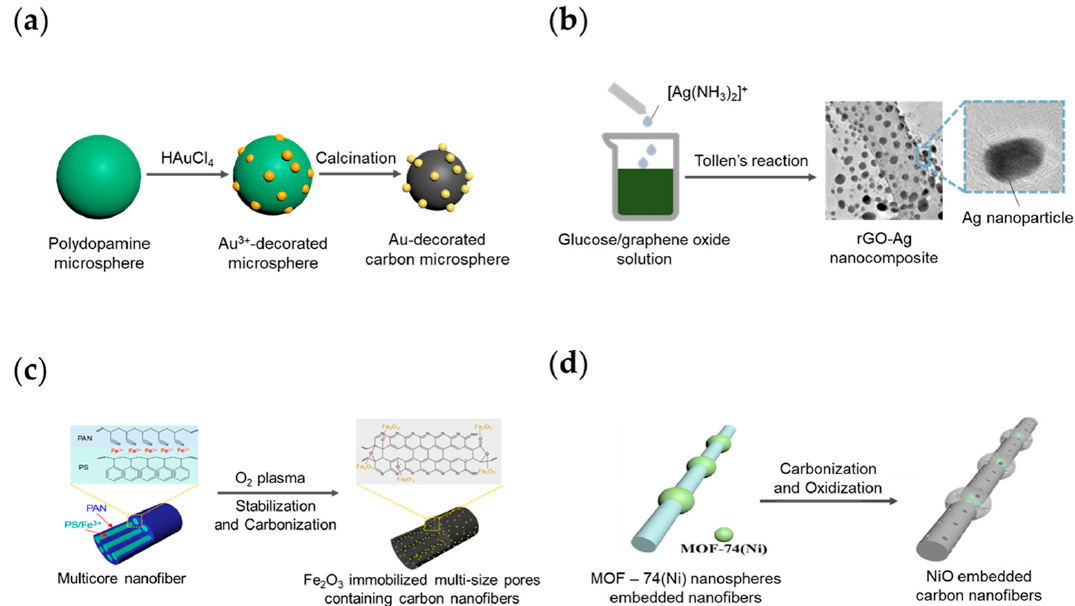
Figure 8. ( a ) Carbon spheres surface modified with in situ synthesized gold nanoparticles [78]. ( b ) The rGO-Ag nanocomposite was synthesized by modified Tollens’ reaction [79]. ( c ) The plasma oxygen process is used to immobilize iron(III) oxide in the multi-dimensional pore structure of carbon nanofibers [80]. ( d ) MOF-74(Ni) nanospheres dispersed in electrospun nanofibers create mesopores in the structure of the carbon fiber after carbonization and oxidation [81].